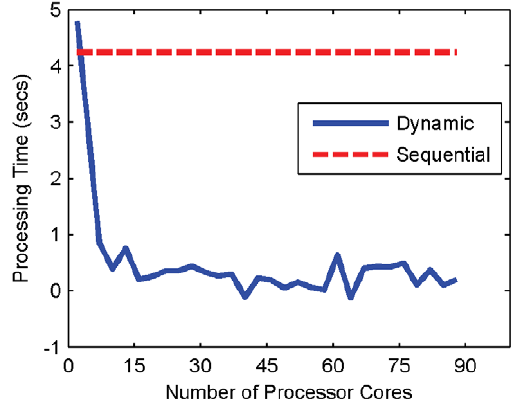
Fig. 7. Runtime for calculating texture features (without loading and saving) for TMA2. The solid line indicates the texture calcu- lation time using centralised dynamic load balancing, whereas the dashed line is the time taken for sequential code using 1 proces- sor core. (Colours are visible in the online version of the article;